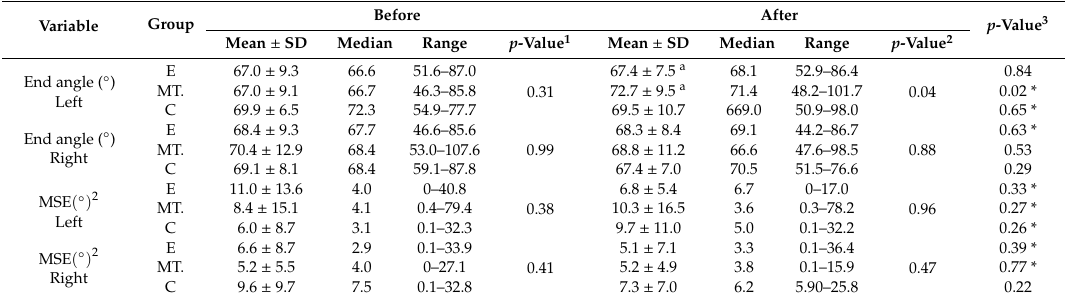
Table 2. Results of proprioception evaluation (end angle for JPS test and MSE) in E, MT, and C groups of participants.